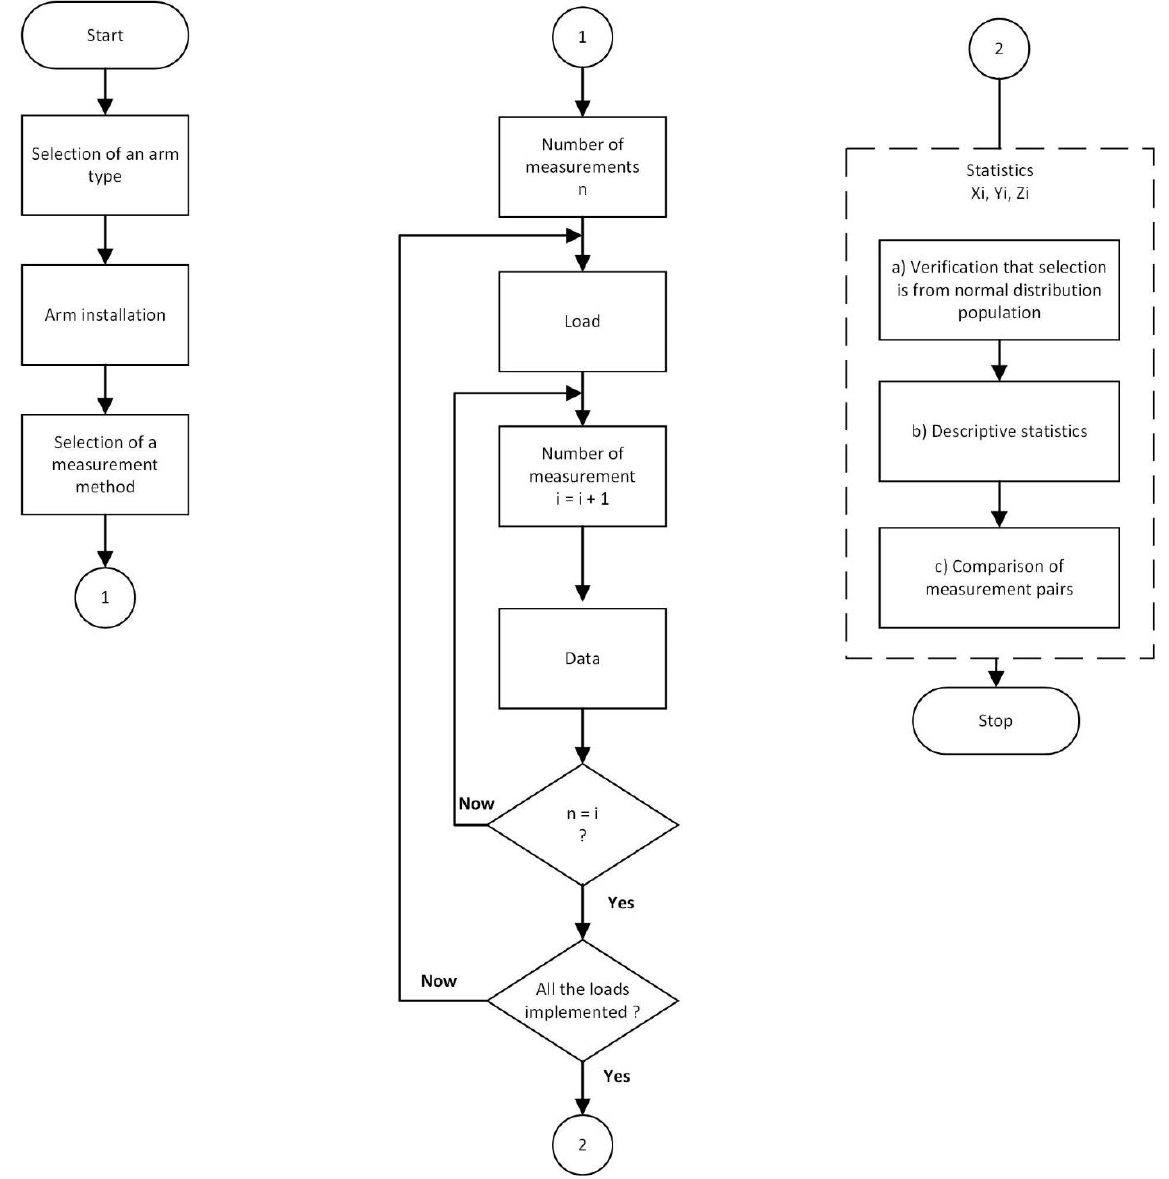
Figure 9. Procedure for measuring and evaluation of a robotic arm’s position